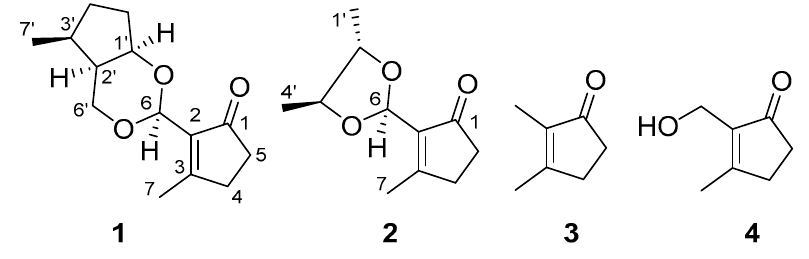
Figure 1. The chemical structures of compounds 1 – 4 .